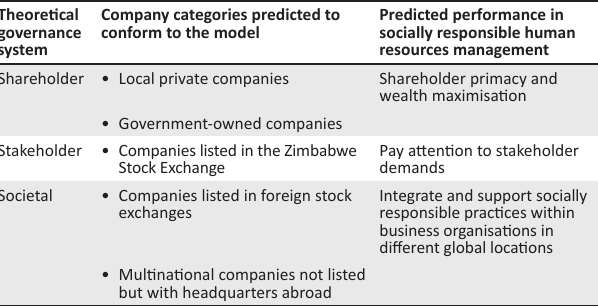
TABLE 1: Corporate governance systems and predicted